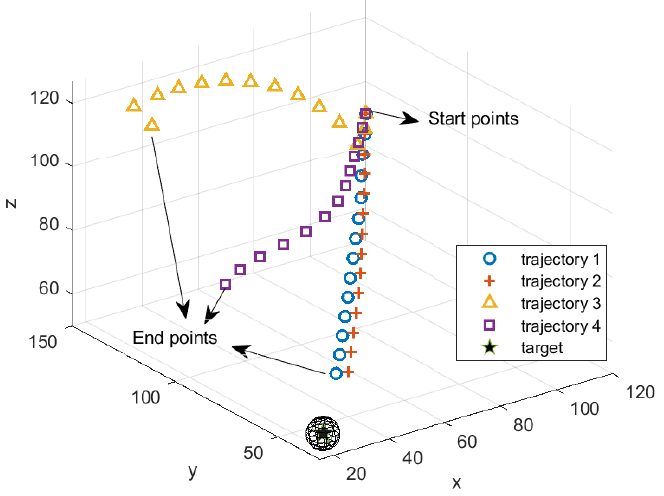
Figure 10. Sensor trajectories in typical runs. The trajectories in other runs are similar to the ones in this run. Trajectories 1, 2, 3 and 4 are represented by circle, cross, upper triangle and square, respectively. The black sphere is the boundary of the target safety area. The target position represented by the five pointed